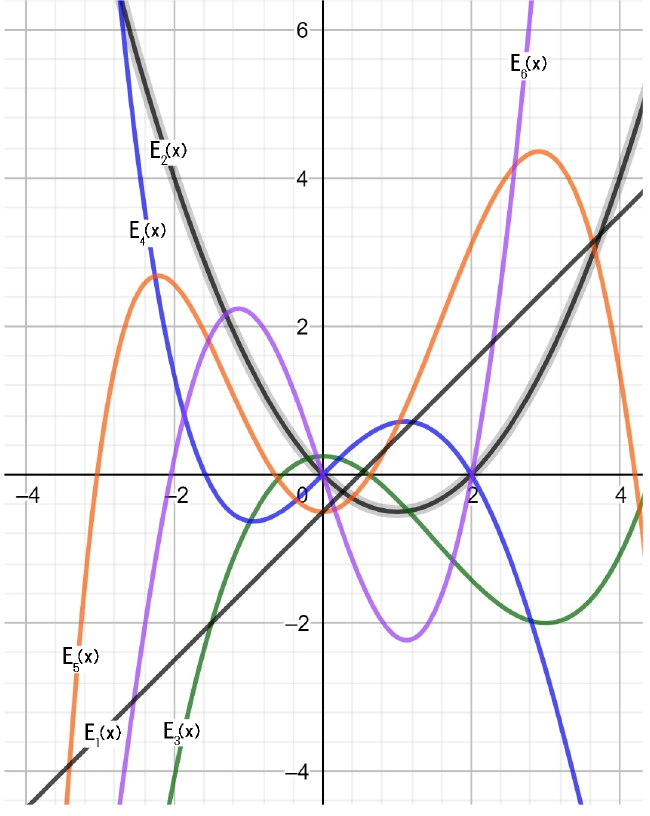
Figure 2. Graphs of polynomials L E n ( x ) for n = 1,2, . . .